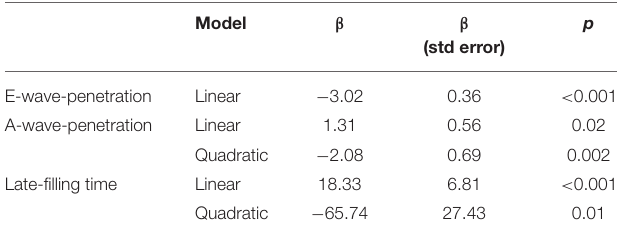
TABLE 2 | Univariate analysis of the relationship between RT and diastolic indices. TABLE 3 | Multivariate analysis between RT and diastolic